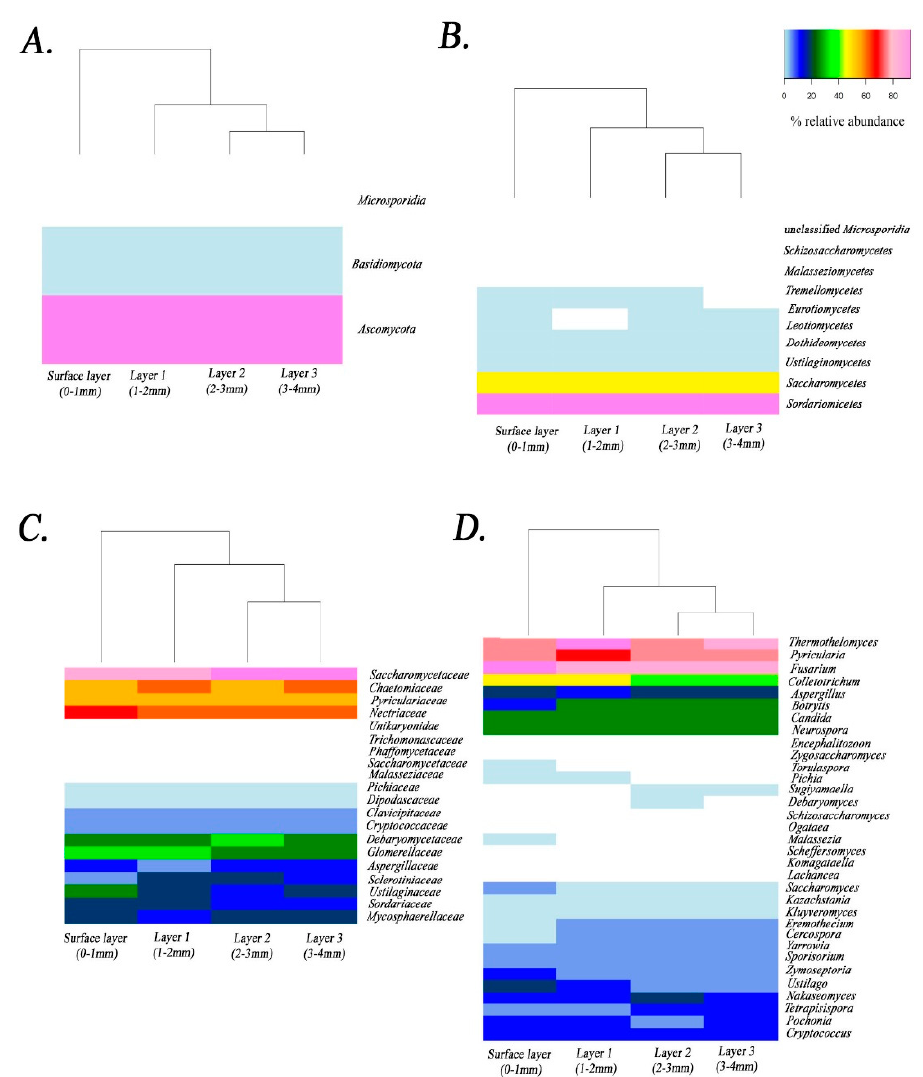
Figure 4. Heatmap showing the relative abundance of fungal taxa at Phylum ( A ), Class ( B ), Family ( C ) and Genus level ( D ) detected by read-based classification of metagenomic sequencing in the different layers [layer 1 (0–1 mm from surface), layer 2 (1–2 mm from surface), layer 3 (2–3 mm from surface), layer 4 (3–4 mm from